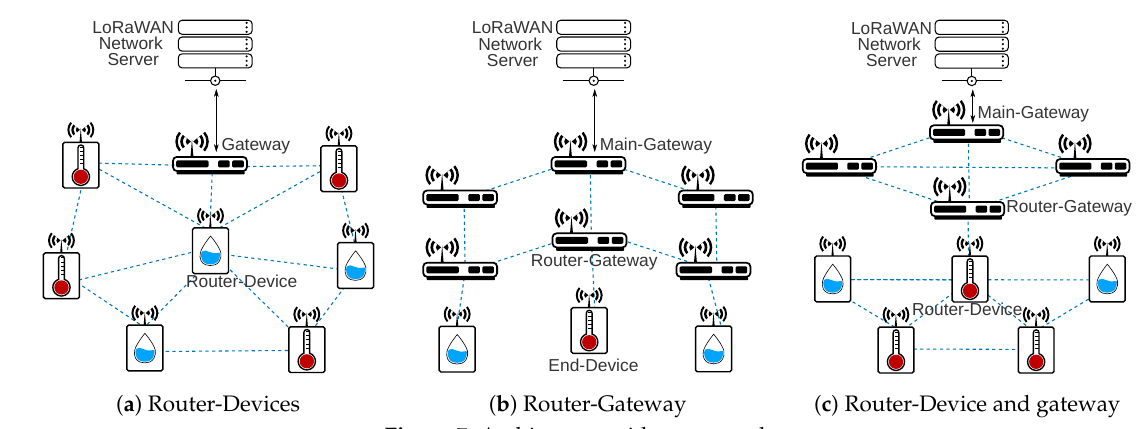
Figure 7. Architecture with router nodes.